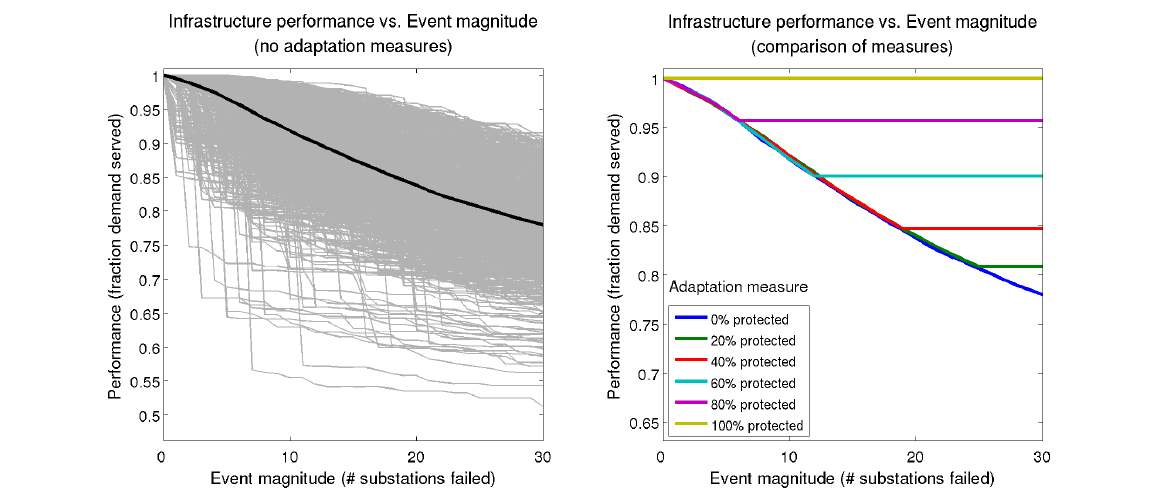
Figure 5. Performance of the modelled infrastructure vs. magnitude of the flood event. The left pane illustrates infrastructure performance with no adaptations in place. The right pane compares infrastructure performance with different adaptations implemented. The gray lines in the left pane indicate the results of individual model runs, and the thicker black line shows the mean of these results. The lines in the right pane indicate the mean performance across all runs for each adaptation scenario. Please be aware of the differing vertical axis scales between the two